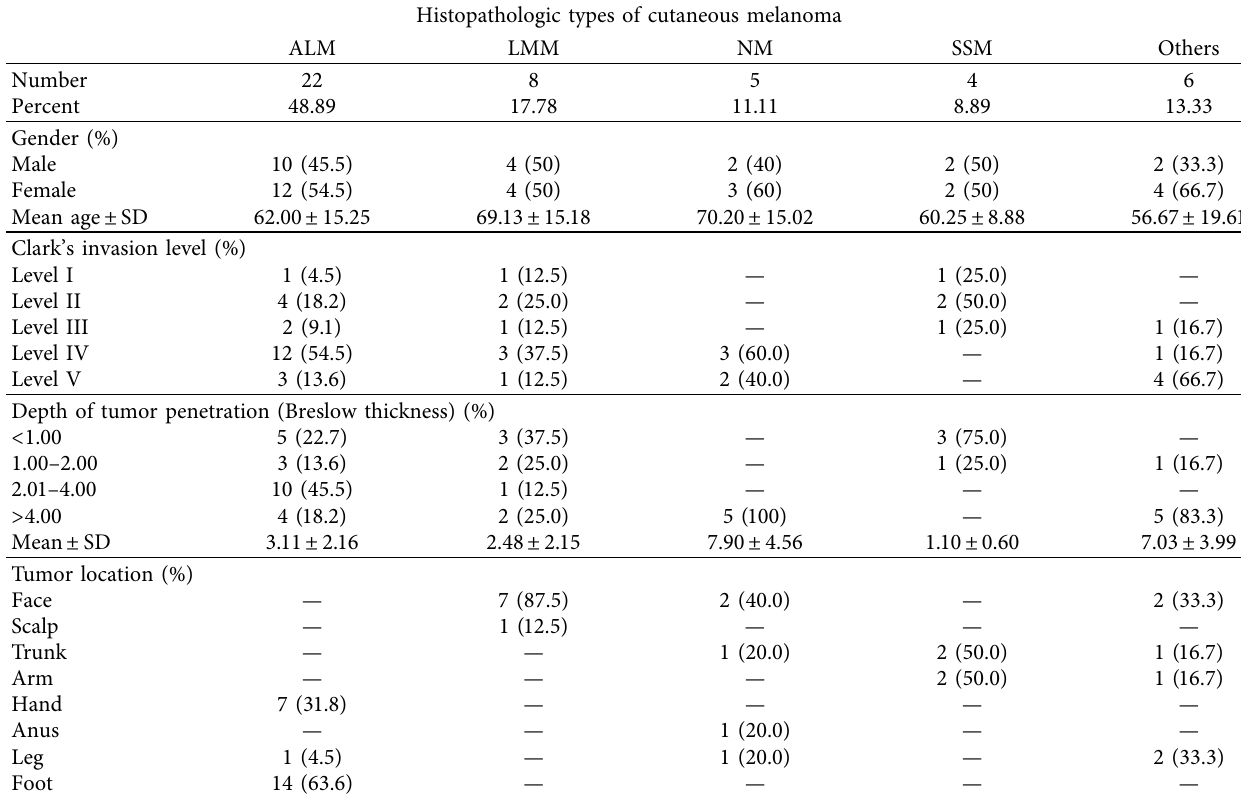
Table 1: The frequency distribution of multiple variables based on histopathologic subtypes of cutaneous melanoma. Histopathologic types of cutaneous melanoma